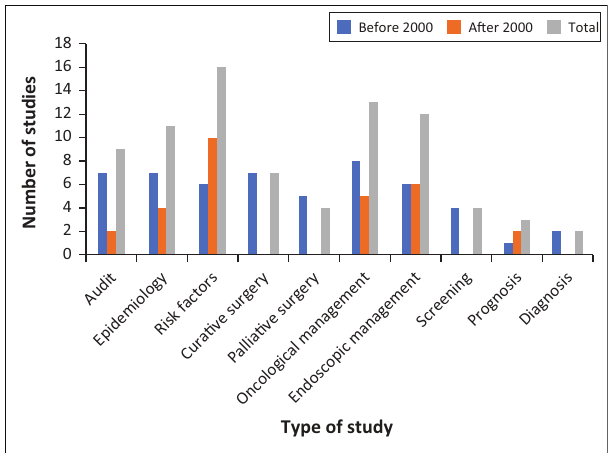
FIGURE 2: Clinical research on oesophageal cancer in South